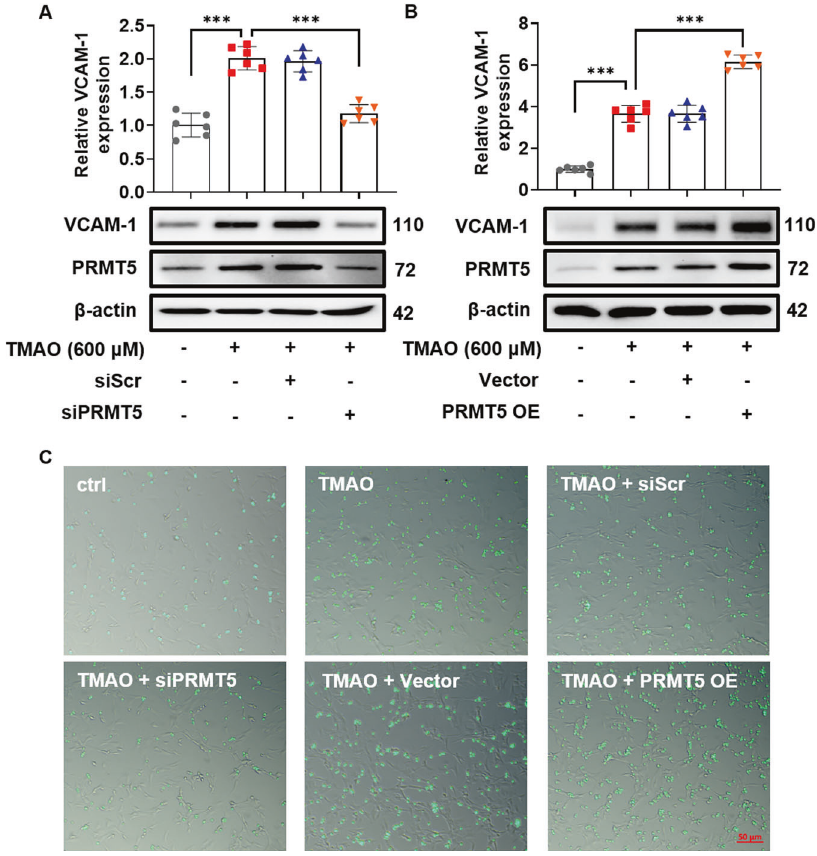
Fig. 2 PRMT5 is responsible for TMAO-induced VCAM-1 expression. VSMC were transfected with PRMT5 siRNA (siPRMT5) or PRMT5 cDNA (PRMT5 OE), then stimulated with TMAO (600 μ M) for 24 h. A , B Representative blots and quantitative analysis of VCAM-1 and PRMT5. The protein expression level was normalized to β -actin. C Representative images obtained by fl uorescence microscope show cell adhesion. Data shown are means ± SD, n = 6 per group from three independent experiments. *** P < 0.001 using a one-way ANOVA followed by Tukey ’ s post hoc